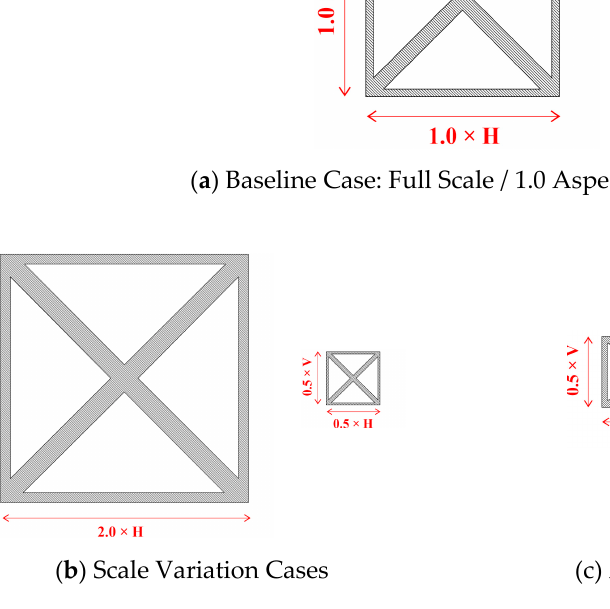
Figure 5. The parameter design space for the considered cases.